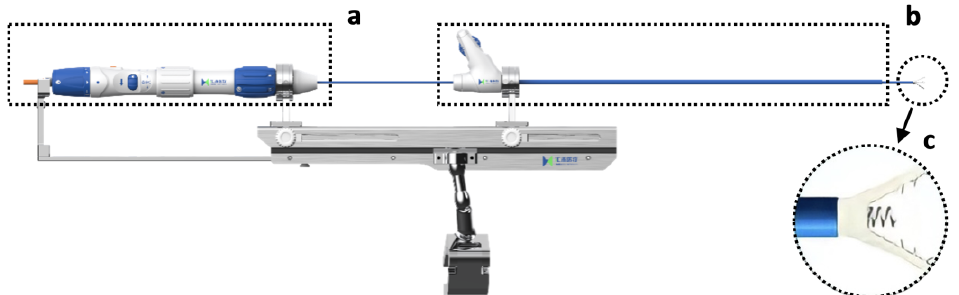
Figure 1. The K-Clip TM system. ( a ) The delivery module. ( b ) The guide sheath and its corresponding control module. ( c ) The clamp arms and the tapping screw in between.